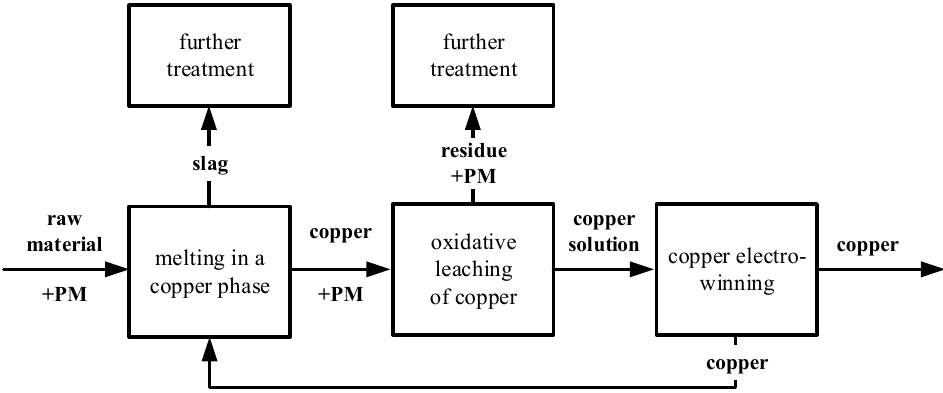
Figure 1. Recycling process for materials containing precious metals (PM), (simplified and modified according to [2]).